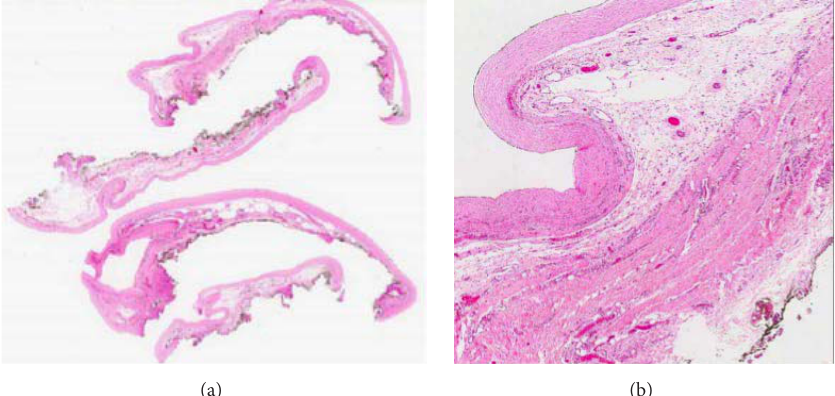
Figure 2: Histology of the cyst wall in (a) 0.3 times magnification and (b) 2 times magnification featuring a fibrocollagenous wall and underlying loose connective